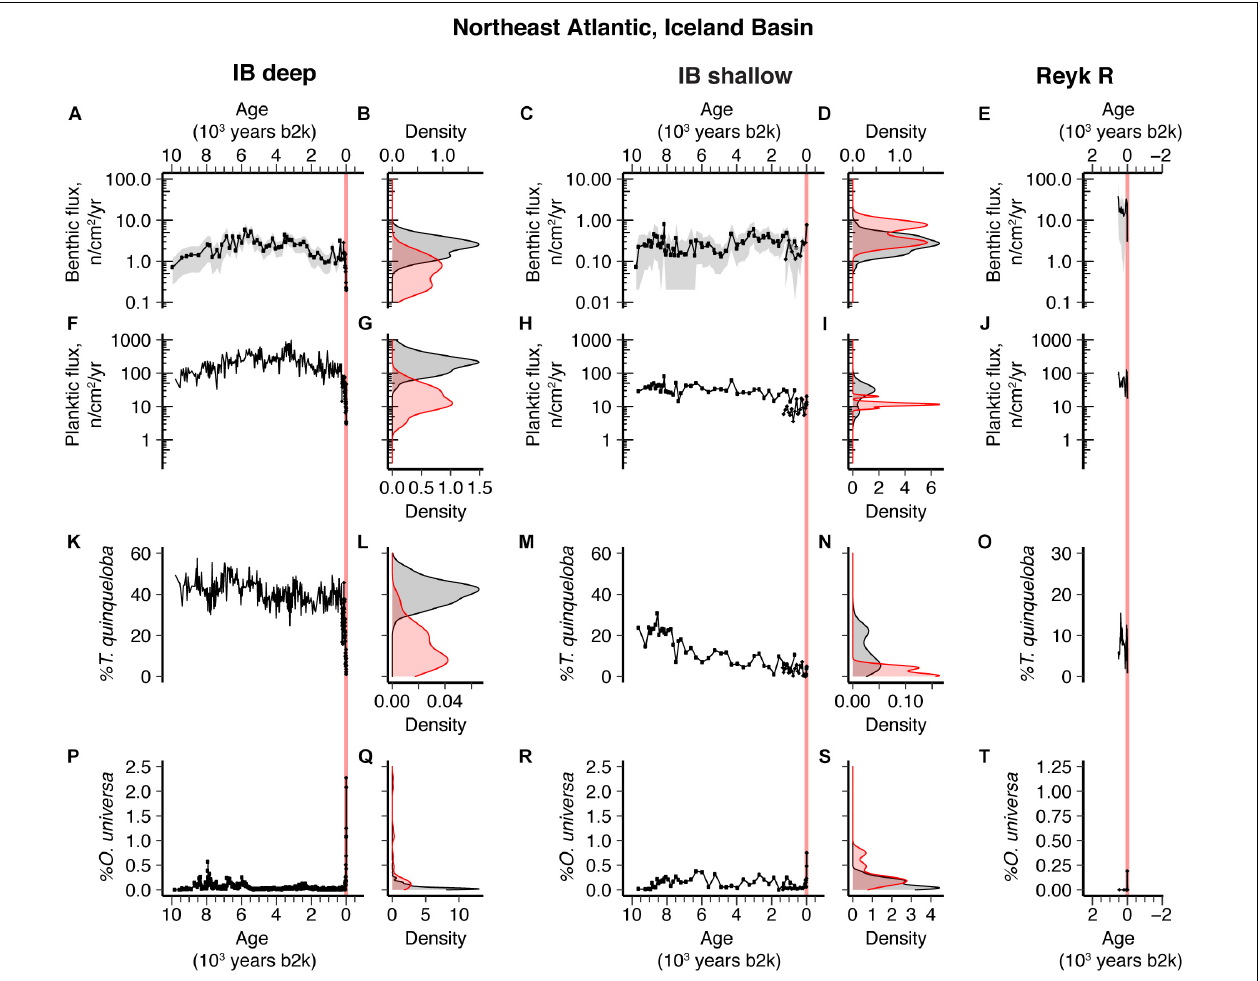
FIGURE 3 | Ten thousand-year northeast Atlantic sediment records and density distribution plots comparing the distribution of Holocene (black) versus industrial era (red) data from IB deep (A,B,F,G,K,L,P,Q) , IB shallow (C,D,H,I,M,N,R,S) , and Reyk R (E,J,O,T) . (A–E) Benthic foraminifer flux; (F–J) planktic foraminifer flux; (K–O) Turborotalita quinqueloba % abundance; Orbulina universa % abundance (P–T) . Turborotalita quinqueloba % abundance in IB deep and Reyk R, and Orbulina universa % abundance data in IB deep, are from Spooner et al. (2020). Benthic abundance data (benthics g - 1 ) for IB deep and planktic abundance data (planktics g - 1 ) for IB deep and Reyk R were previously published (Spooner et al., 2020) and have been converted to benthic and planktic fluxes, respectively (this study). Vertical red-shaded band indicates industrial era. Gray-shading in the benthic flux time series plots represents 2 σ